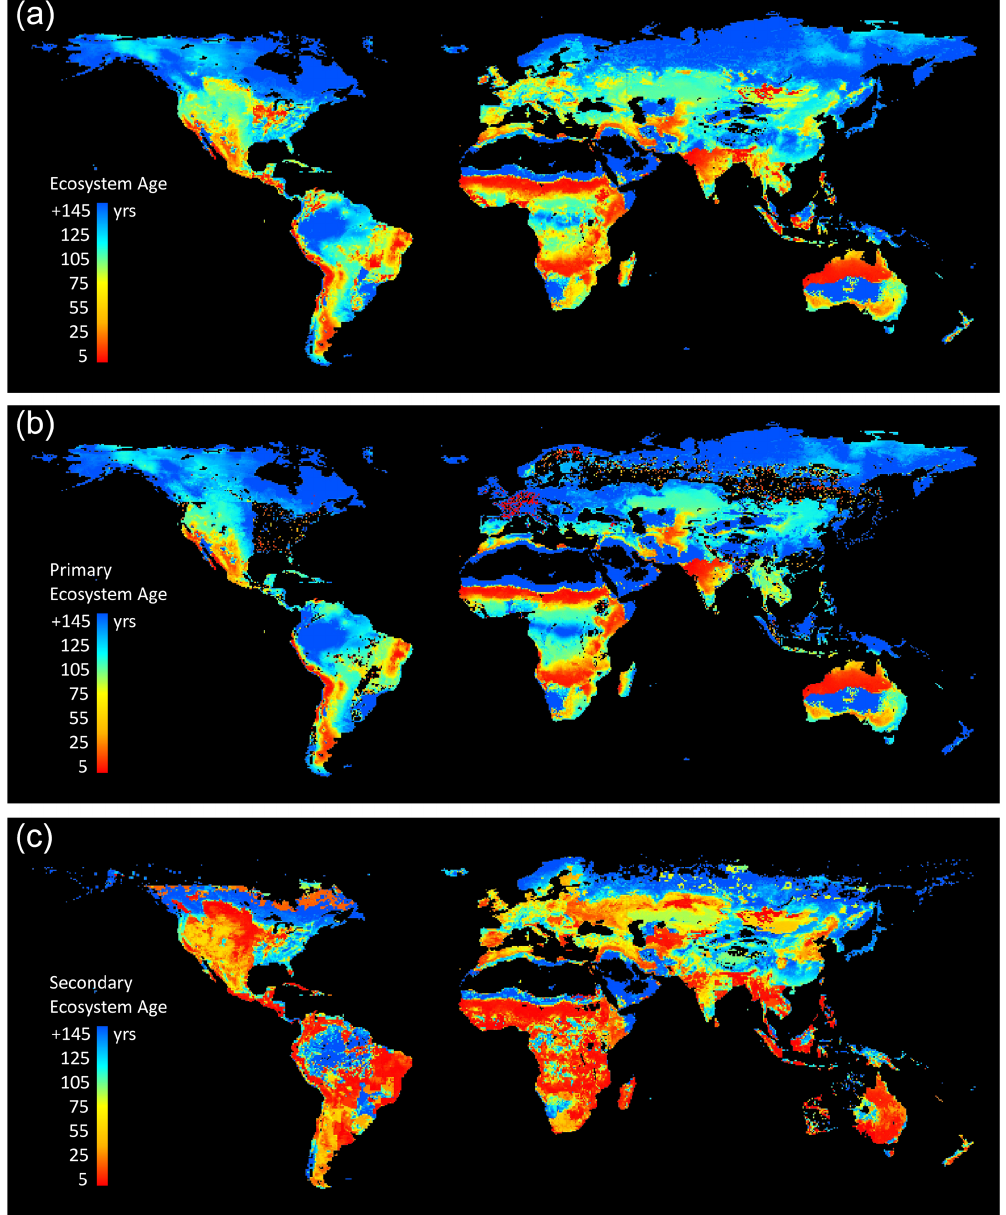
Figure 13. LPJ-wsl v2.0 simulated global distribution of ecosystem ages, defined as the time since disturbance by fire and/or LUCLM in the year 2016. (a) Average age of the natural ecosystem, scaled to the area of natural lands within 0.5 ◦ grid cells. (b) Average age of primary ecosystems only, wherein only fire creates age structure, scaled to the area of primary lands. (c) Average age of secondary ecosystems only, wherein fire and LUCLM create age structure, scaled to the area of secondary